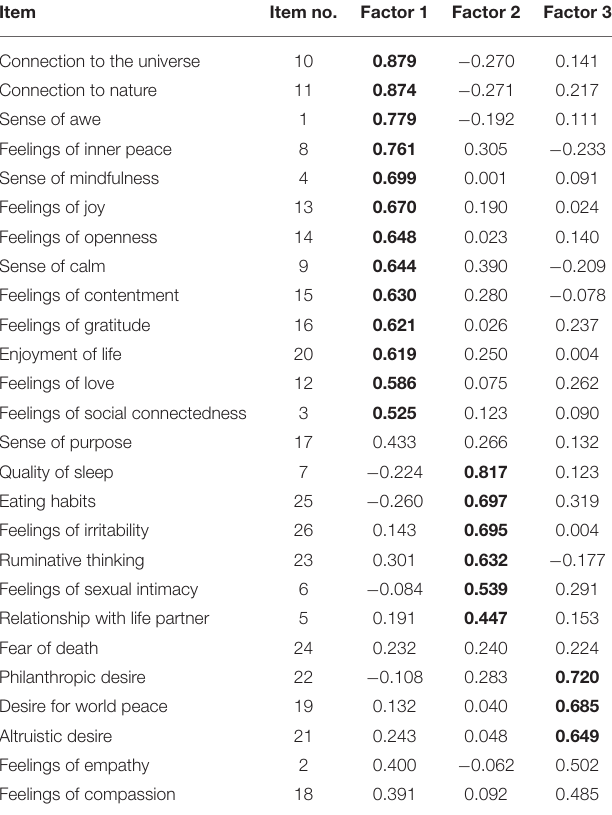
TABLE 5 | Number and percentages of negative responses.